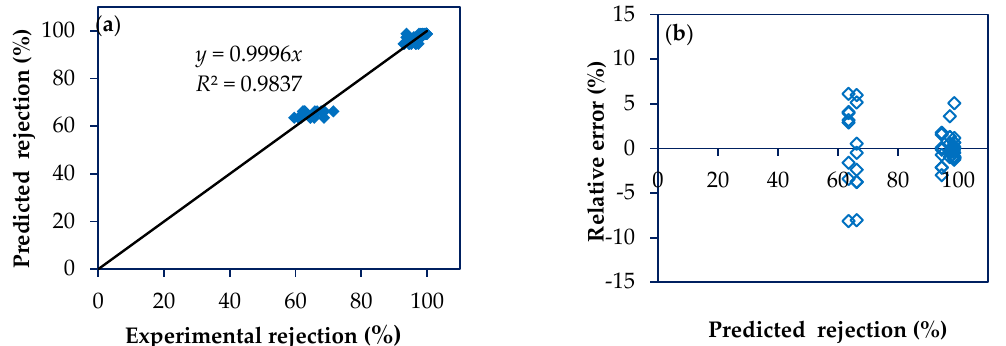
Figure 3. Scatter diagram for the permeate flux model. ( a ) Plot of predicted permeate fluxes vs. experimental permeate fluxes; ( b ) Plot of relative error as a function of predicted permeate flux. Permeate fluxes are given in kg h −1 m −2 .